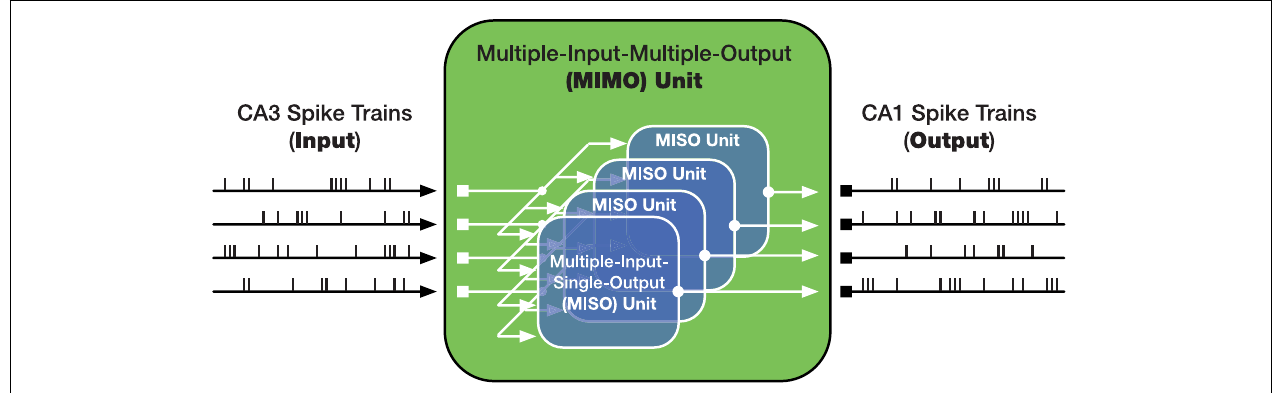
FIGURE 1 | Graphical representation of the mathematical model developed by Berger et al. (2011) to simulate connectivity between CA3 and CA1 of the hippocampus. Figure adapted from Berger et al.